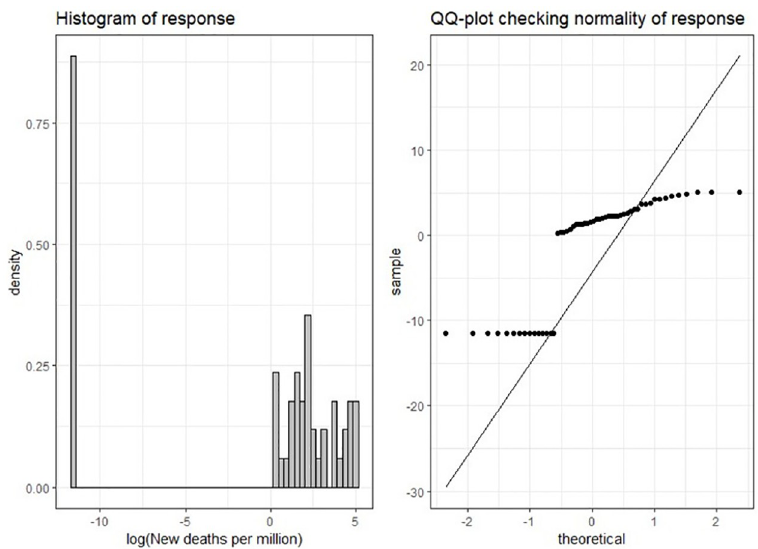
Fig 8. Histogram and QQ plot of log(new deaths per million) in Europe during January-April, 2020.